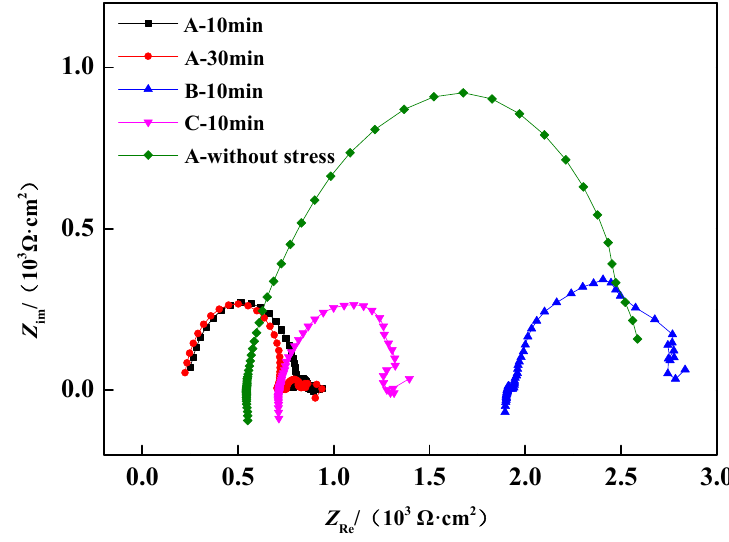
Figure 3. Nyquist curves of steel wires of different cases in NH 4 SCN solution.